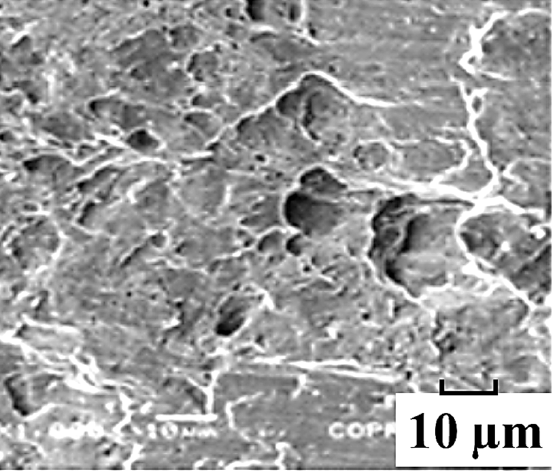
Figure 2. A typical example of hydrogen embrittlement on X46 carbon steel [15]. Reprinted with permission from [15], 2014, Elsevier.